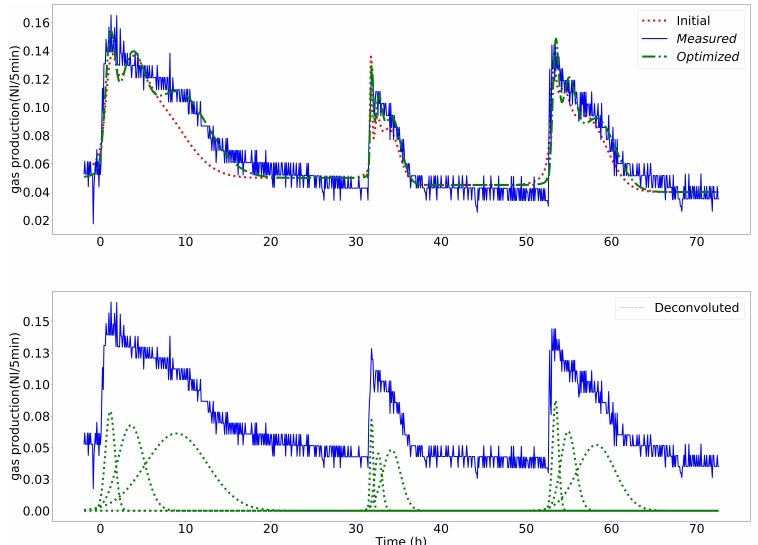
Figure 7. Gaussian fit of the curves 1, 2 and 3 (see Figure 4). Upper Figure shows the fitted gas production rate course (green) in comparison to the measured (blue) and the course calculated with initial values (red). Lower Figure shows the separated Gaussian functions (green) for each curve.